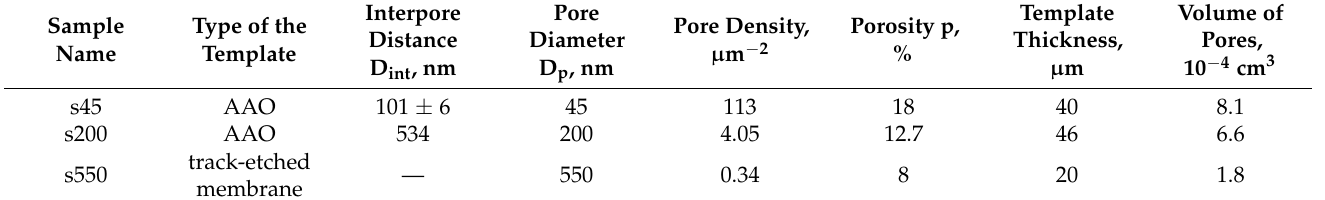
Figure 3. Scheme of pore arrangement ( a ) and SEM images of the surface of AAO film s45 ( b ) and polymer track-etched membrane s550 ( c ). Table 1. Parameters of AAO films and polymer track-etched membranes, used as templates.